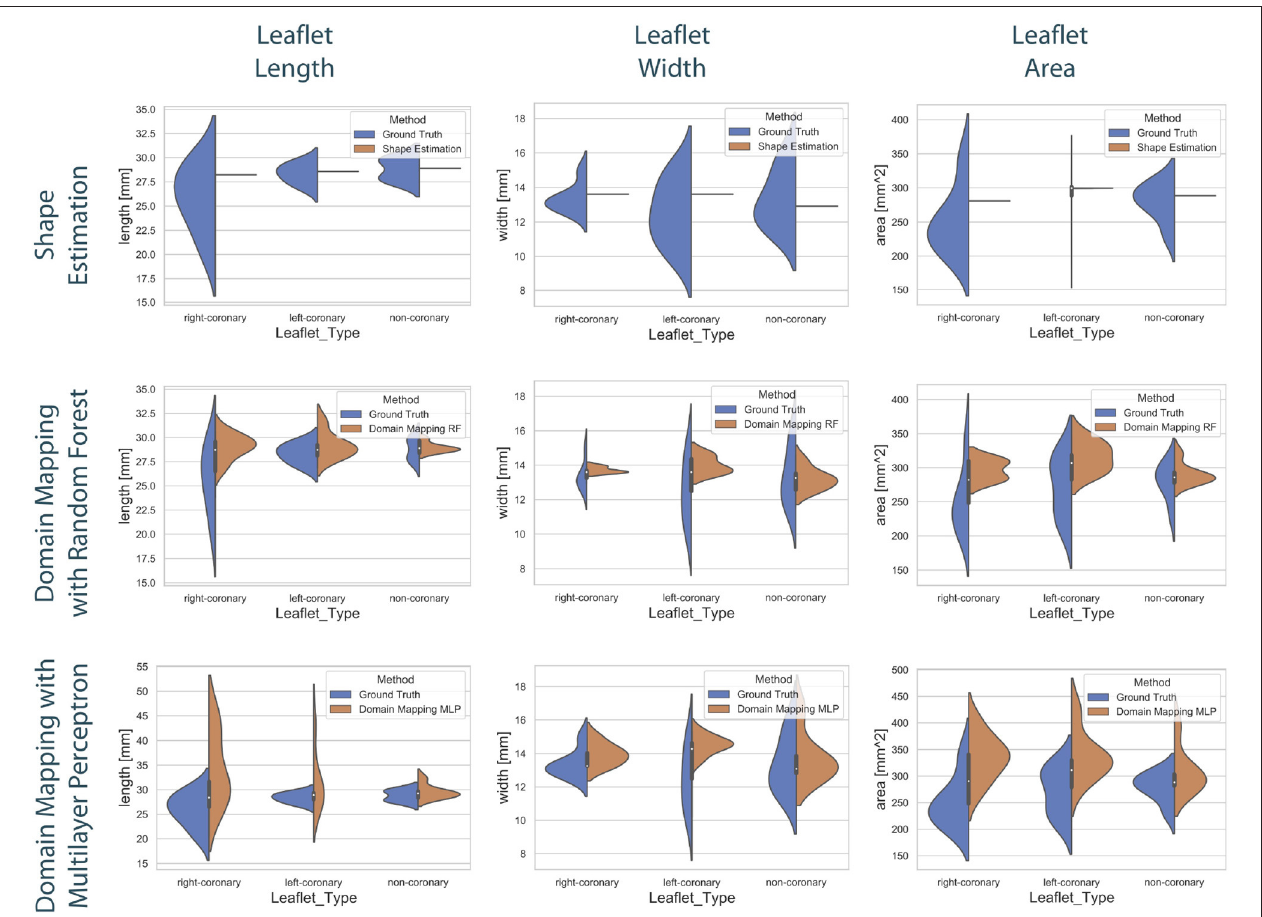
FIGURE 8 | Distribution of the predicted leaflet shapes in comparison to the true distribution of the dataset D Lf . The columns show the distribution of the length (left) , width (middle) , and area (right) in dependency of the leaflet type for the true distribution given in the dataset (blue) and the distribution in the predicted test set (orange). The rows correspond to the utilized prediction model, i.e., shape estimation (top) , domain mapping with RF (middle) , and domain mapping with MLP (bottom) . While shape estimation fails in predicting a variety of shapes, the MLP-based domain mapping approach outperforms the RF-based one regarding the coverage of the full distribution of observed leaflet